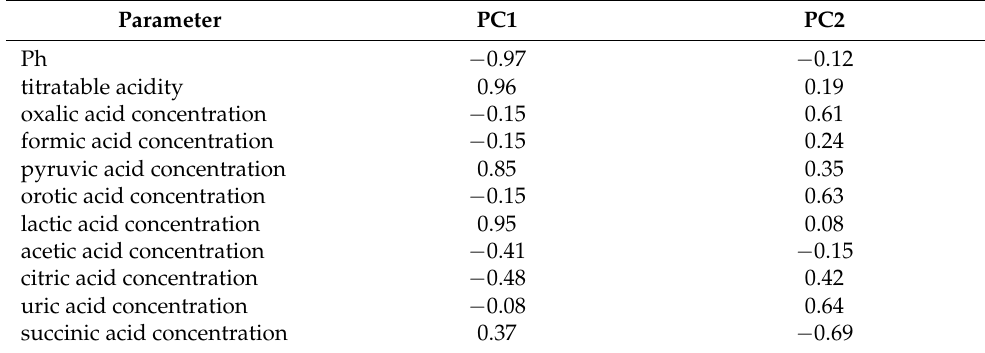
Figure 5. Principal Component Analysis: Effect of cultures (V, W, X, Y, and Z) on pH value, titratable acidity value, and organic acids concentration at the end of fermentation. Table 5. Correlations of each parameter with the two principal components, i.e., the horizontal (PC1) and vertical axis (PC2).